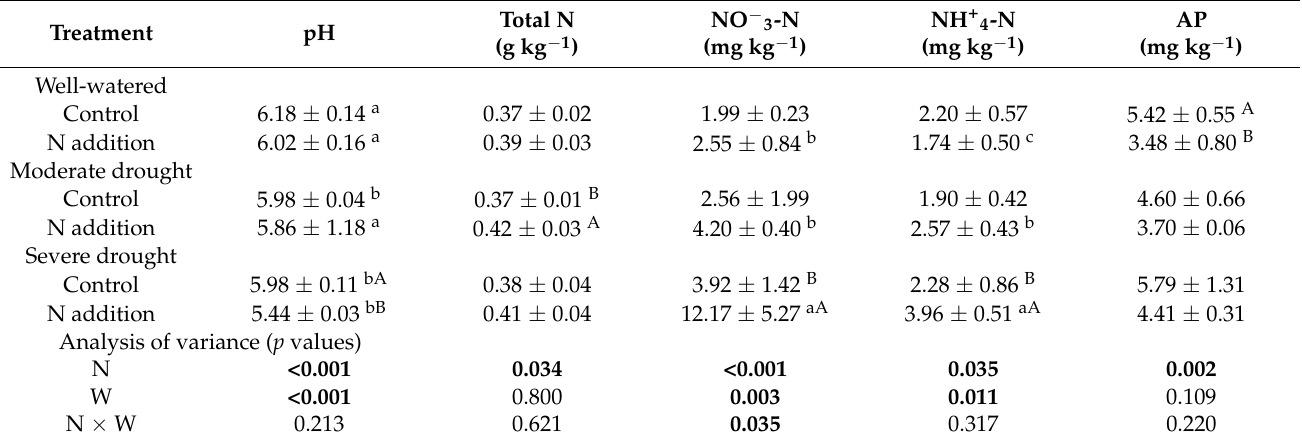
Table 1. Effects of experimental nitrogen addition and drought on soil pH, total N, NO − 3 -N, NH + 4 -N, and available phosphate (AP) contents.